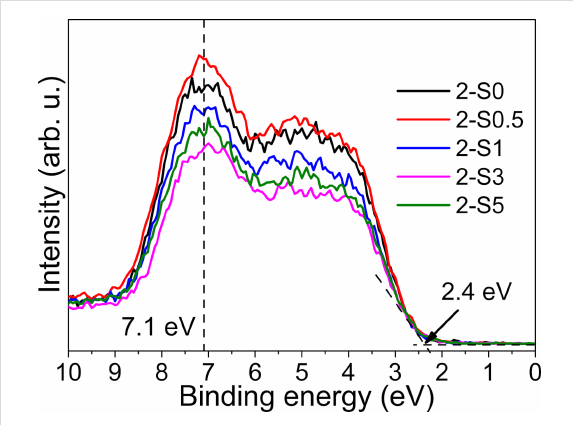
Figure 5: Valence-band XPS of 2-S0, 2-S0.5, 2-S1, 2-S3 and 2-S5.